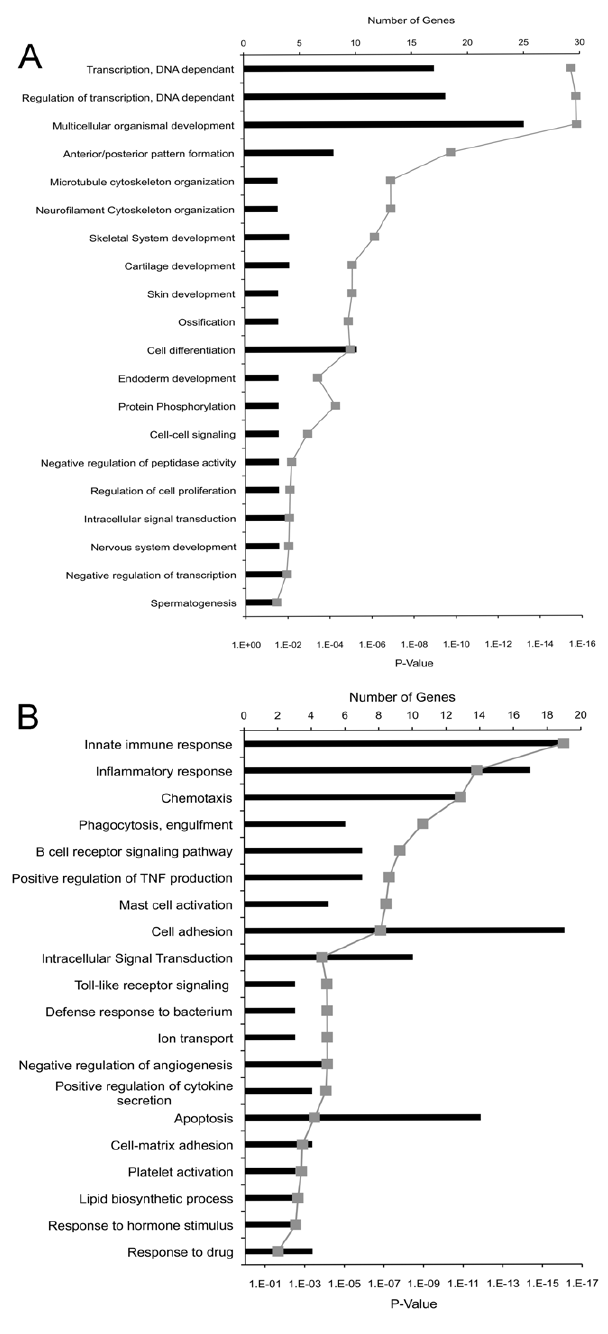
Figure 3. Go term enrichment analysis: General biological processes associated with HDACi-regulated genes. Gene Ontol- ogy (GO) term enrichment analysis was carried out using GENECODIS on (A) 127 genes that are up-regulated by all three drugs, and (B) 373 genes that are down-regulated by all three drugs. Black bars represent the number of genes annotated to the GO terms listed along the y-axis. Grey diamonds indicated the P-value, which represents the probability that an individual gene is associated to a particular GO term based on chance alone.